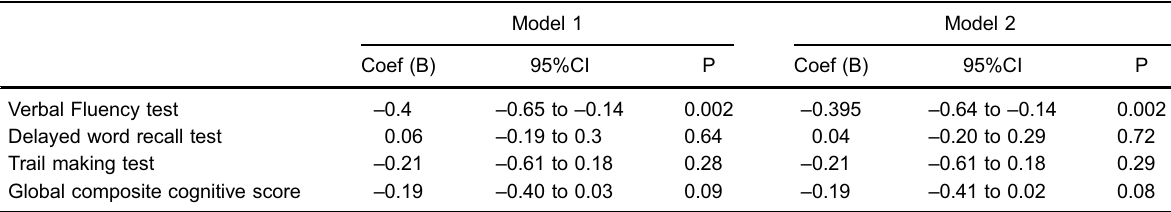
Table 2. Association between cognitive performance and glaucoma in the sample (n=4,331) (wave 1 - baseline - of ELSA-Brasil, 2008 – 2010).